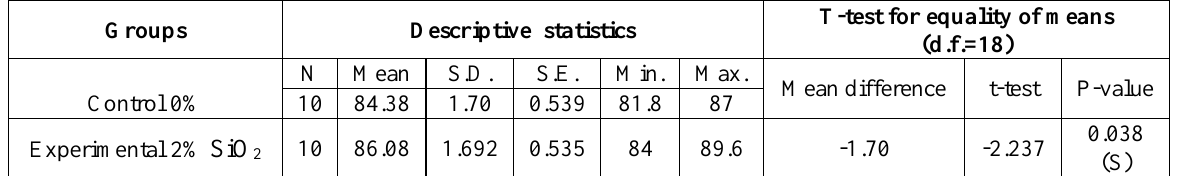
Table 4: Descriptive summary and T-test for surface roughness Descriptive statistics